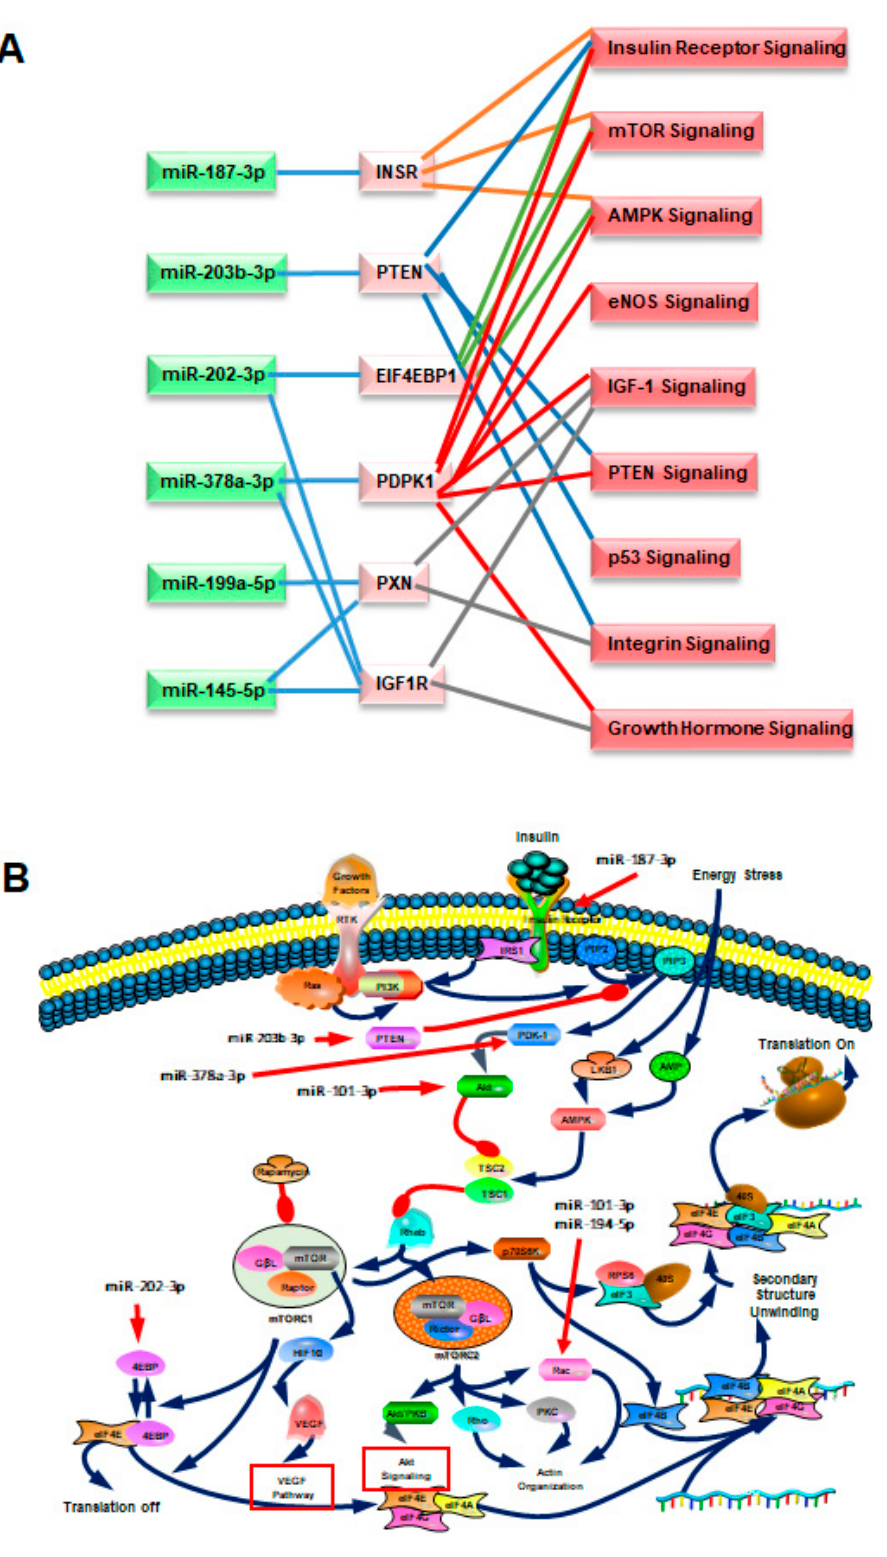
Figure 6. The most common target genes and mTOR pathway regulated by the di ff erentially expressed exosomal miRNAs. ( A ) EIF4EBP1, INSR, PDPK1, PTEN, PXN , and IGF-1R are the most common network genes targeted by the prominent circulating exosomal miRNAs including miR-187-3p, miR-203b-3p, miR-202-3p, miR-378a-3p, miR-199a-5p, and miR-145-5p. ( B ) IPA networks showing the regulatory effects of the differentially expressed miRNAs from rat serum on mTOR signaling.